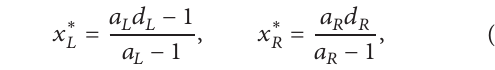
(slopes and border points) may all or in part depend on some economic parameters, so that as an economic parameter is varied, it is also possible that it influences several of the above parameters, leading to particular paths in the parameter space.